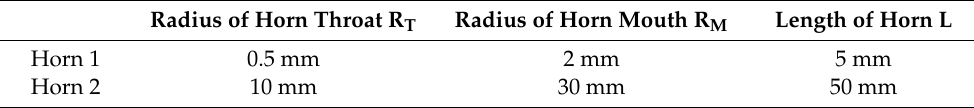
Figure 2. Frequency response curves of: ( a ) amplification factor for Horn 2, the large-sized DC horn with and without consideration of the viscosity of the medium, and the ratio of the two amplification factors; ( b ) amplification factor for Horn 1, the small-sized DC horn with and without consideration of the viscosity of the medium, and the ratio of the two amplification factors. Table 1. Parameters of the acoustic horns with different sizes used in Figure 2.